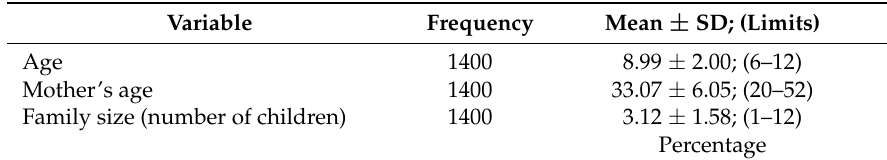
Table 1. Descriptive results of study